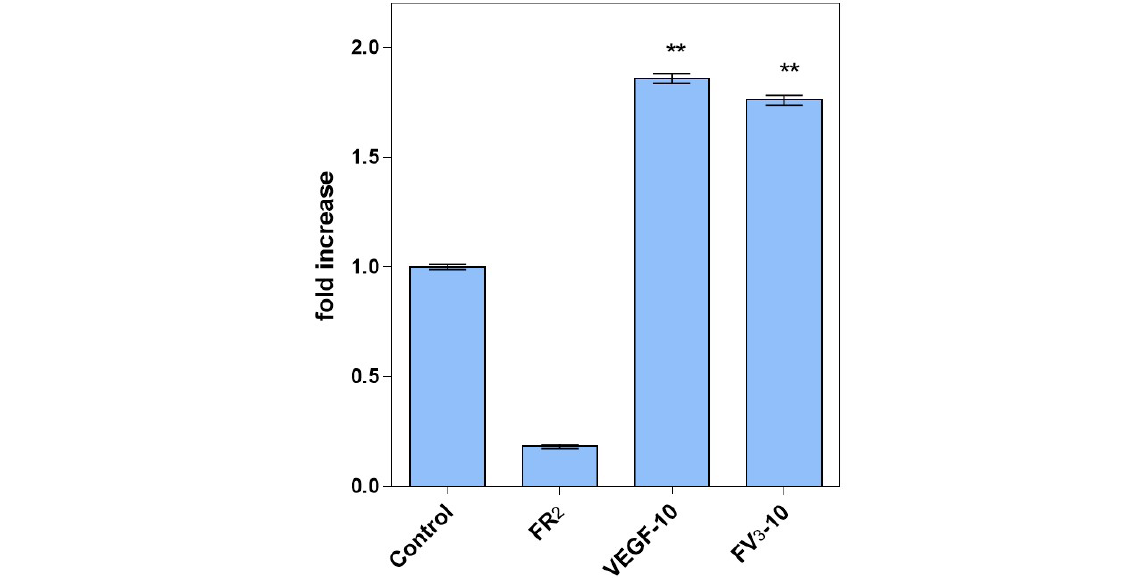
FIGURE 4 - Effects of VEGF-free PCL nanoparticles (FR FV formulation which contains encapsulated VEGF released at a concentration of 10 ng/ml (FV 3 inducing VEGFR-2 (KDR) activation by ELISA is shown (y-axis shows fold increase of VEGFR-2 compared to the untreated control group) ** p